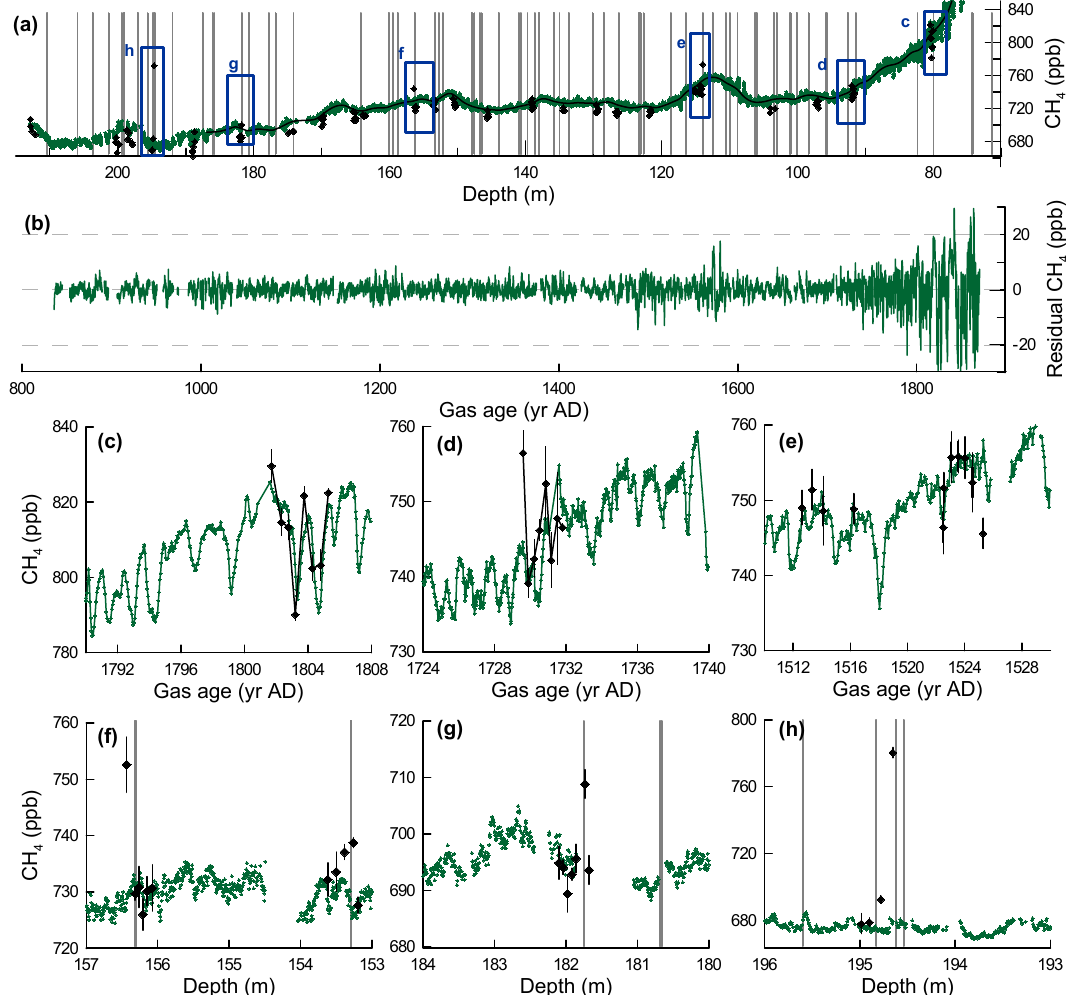
Figure 3. Decimetre-scale CH 4 variability in Tunu13 mature ice captured by continuous (green) and discrete (black diamonds) analyses: (a) both records on depth scale with vertical grey lines indicating depths of bubble-free layers observed; (b) residual high-frequency non- atmospheric component of Tunu13 signal: continuous record (green on panel a ) minus cubic spline fit (black line on panel a ). Data from below 172m depth are excluded because there are too many data gaps resulting from poor core quality. Y axis has been clipped at − 30 and + 30ppb. Data minimum and maximum are − 38 and 36ppb; c–h ) Zoomed views of high-frequency CH 4 variability within blue rectangles displayed on panel (a) . CH 4 concentrations of discrete data points are increased by 8.5ppb on panels (c) – (h) to aid comparison with continuous data. 2 σ internal precision uncertainty bars are plotted for discrete data. Horizontal bars on discrete measurements represent depth interval of each sample. Depth uncertainty for the continuous data is estimated to be ± 2cm (2 σ